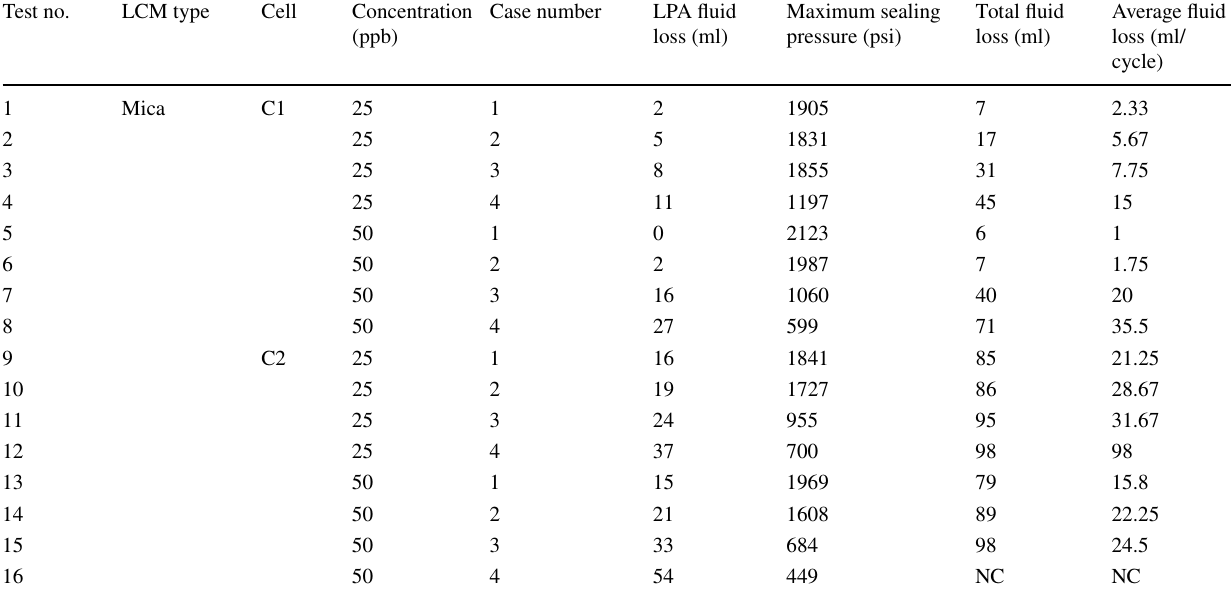
Table 7 Summary of HPA testing results for Mica Test no.